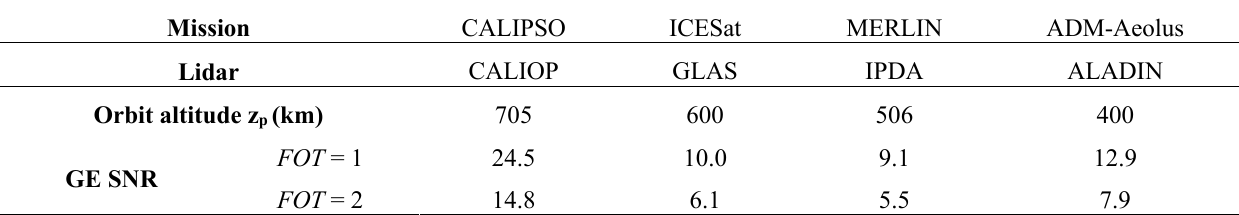
Mission CALIPSO ICESat